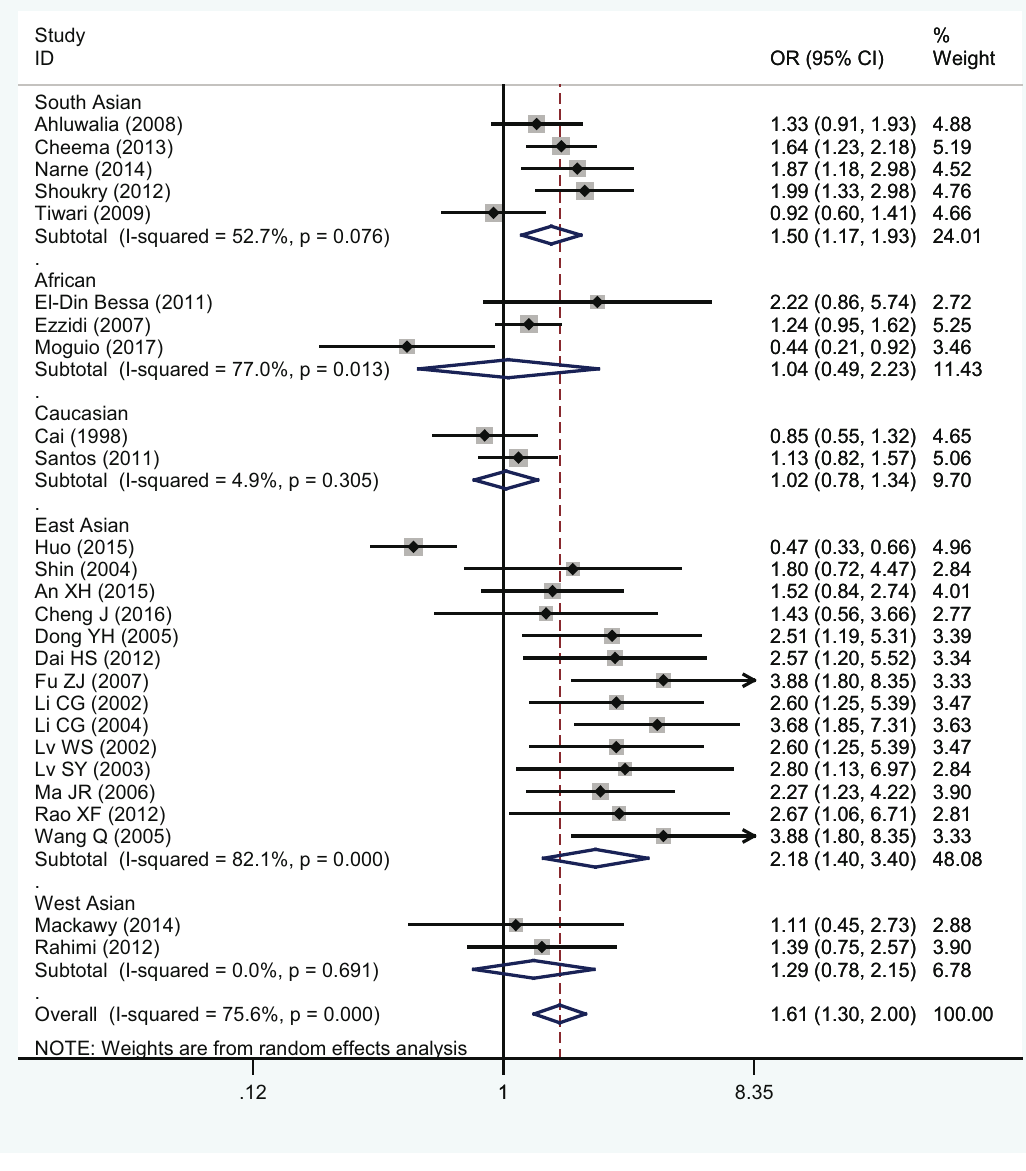
Figure 3: Forest plot of eNOS 894 G < T polymorphism and DN susceptibility in dominant gene model ( TT + GT ) vs